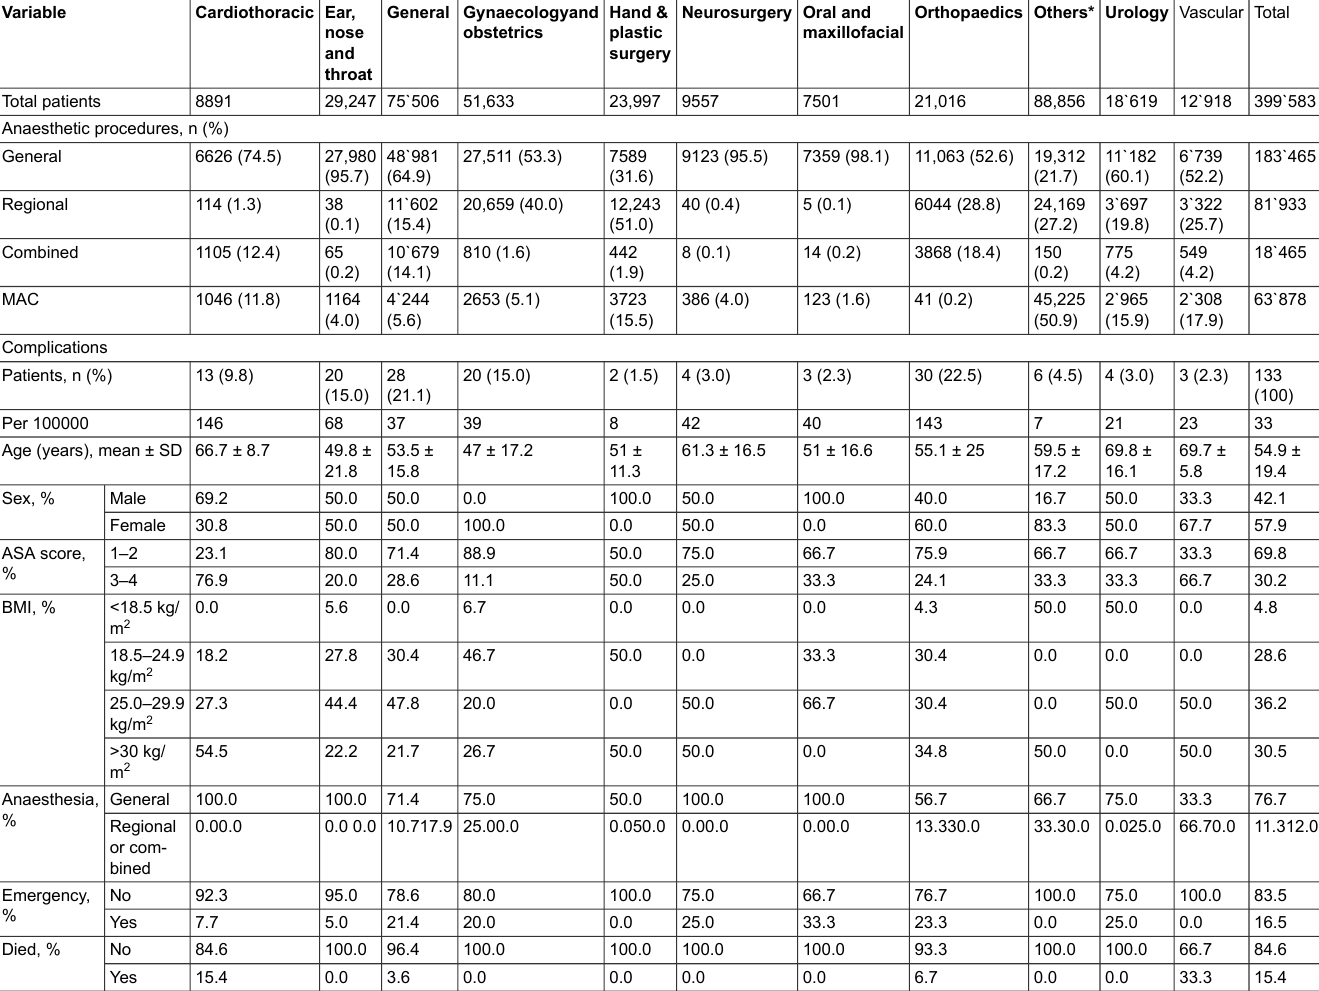
Table 4: Summary of complication incidences and patient descriptive statistics by hospital department with total anaesthesia numbers between 2003-2019.